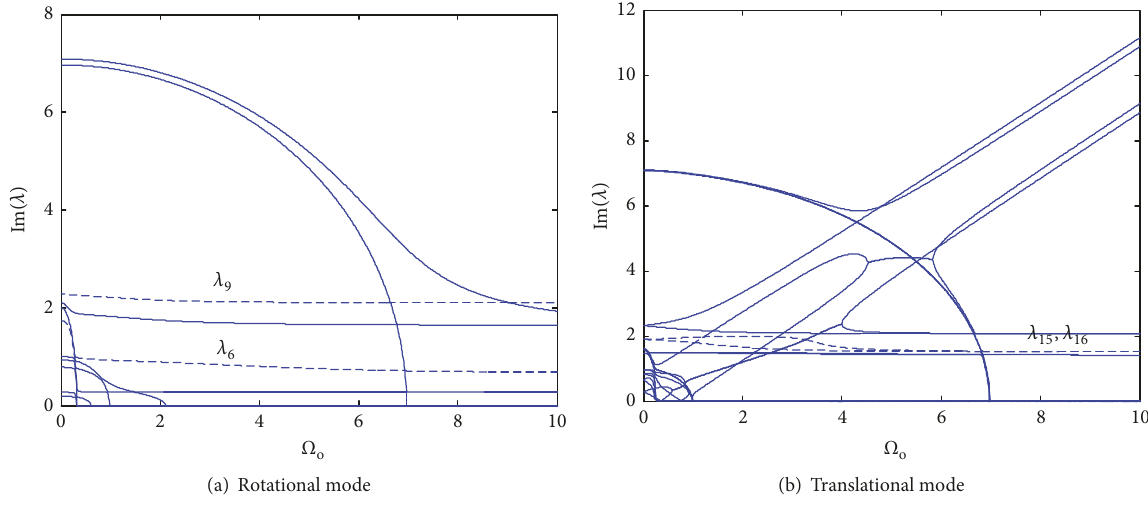
Figure 8: Influence of crankshaft eccentricity.